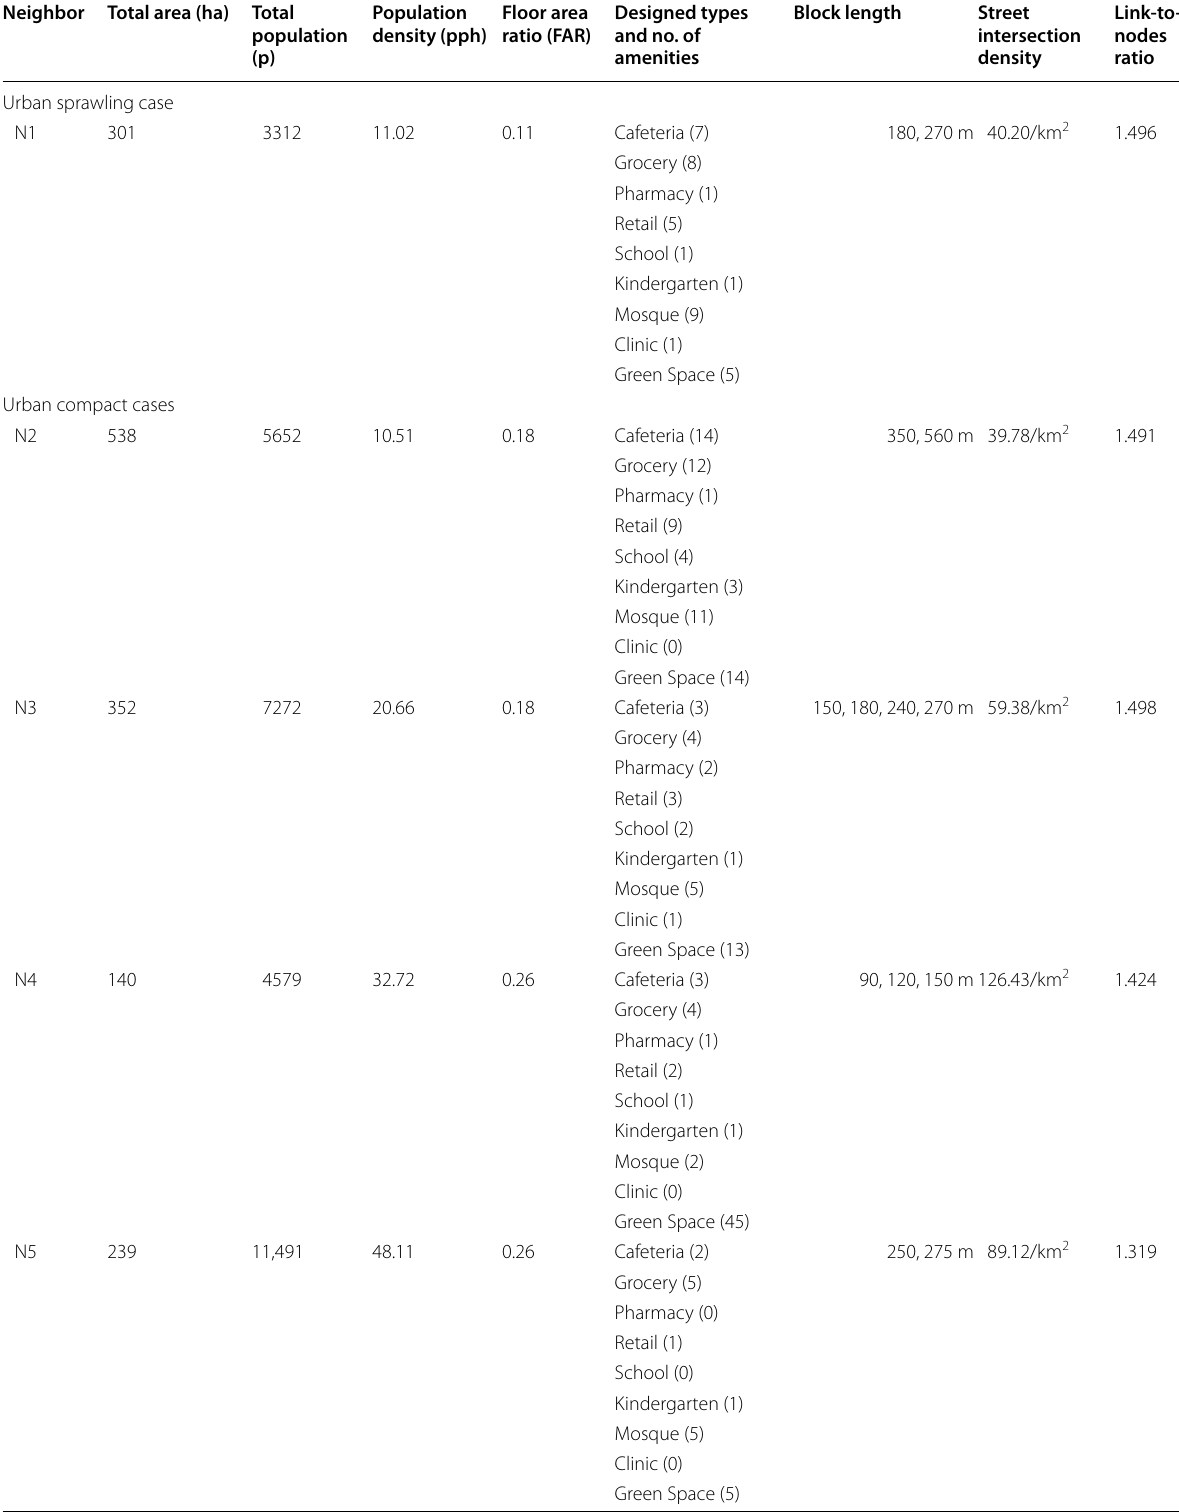
Table 4 Summary of the macroscale urban morphological indicators of the studied neighborhoods Neighbor Total area (ha) Total